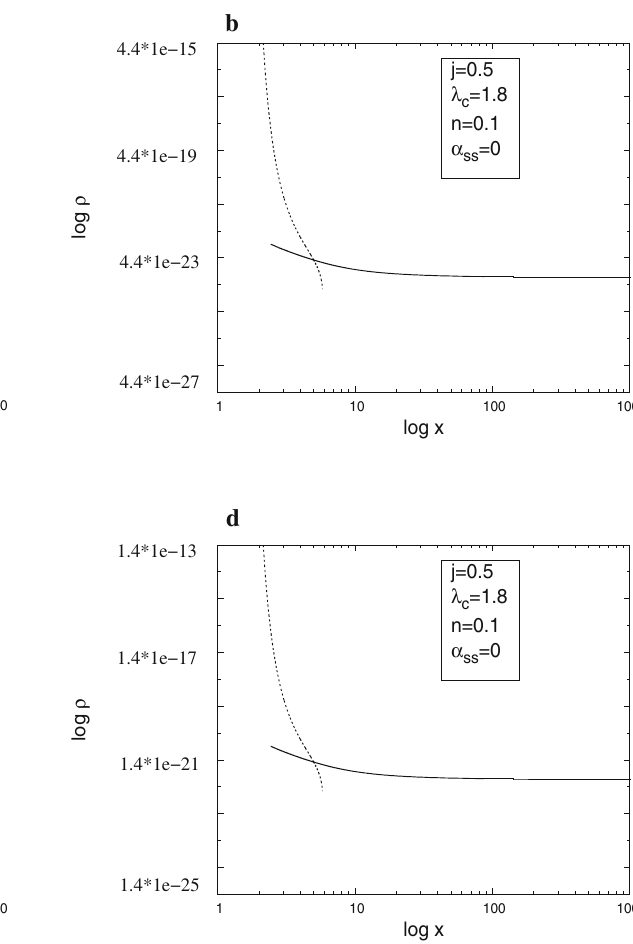
accretion disc flow around a non-rotating BH for MCG using NFW and Einasto profile respectively. Accretion and wind curves are depicted by solid and dotted lines